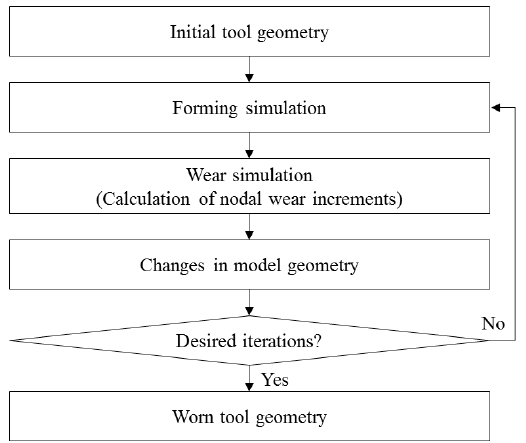
Figure 10. Process of wear simulation based on the modified Archard’s wear model.